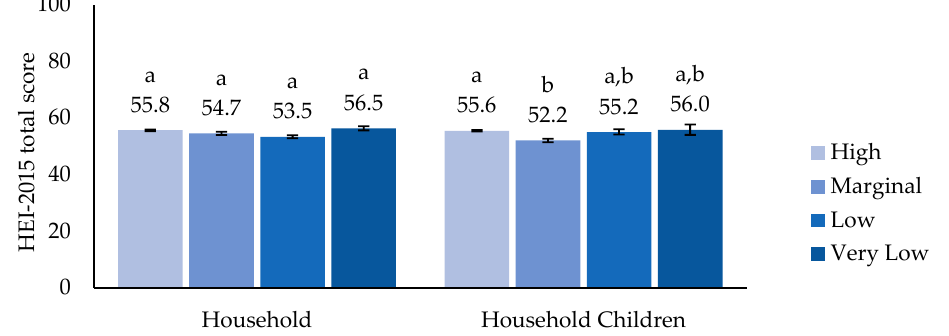
Figure 1. Healthy Eating Index (HEI) 2015 total score of U.S. children (2–17 years) by household food security and food security among household children. Estimates with different alphabet letters are significantly different based on pairwise t-tests within each classification at p -value < 0.05.